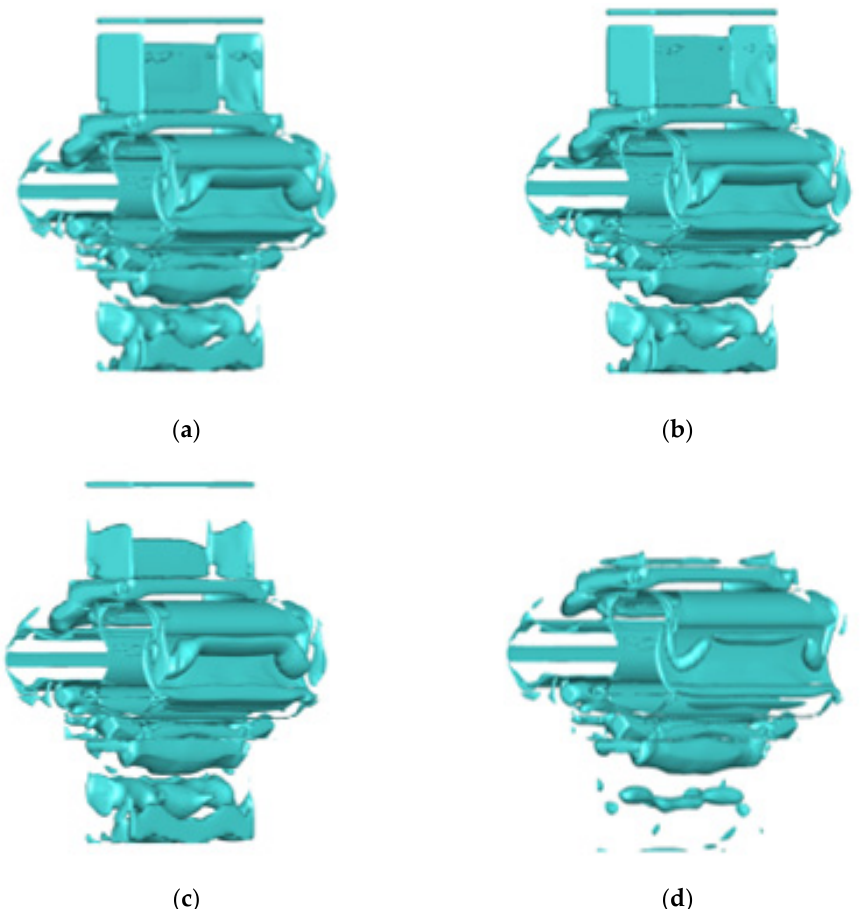
Figure 14. Q criterion vortex identification results of the Roots pump flow field at different